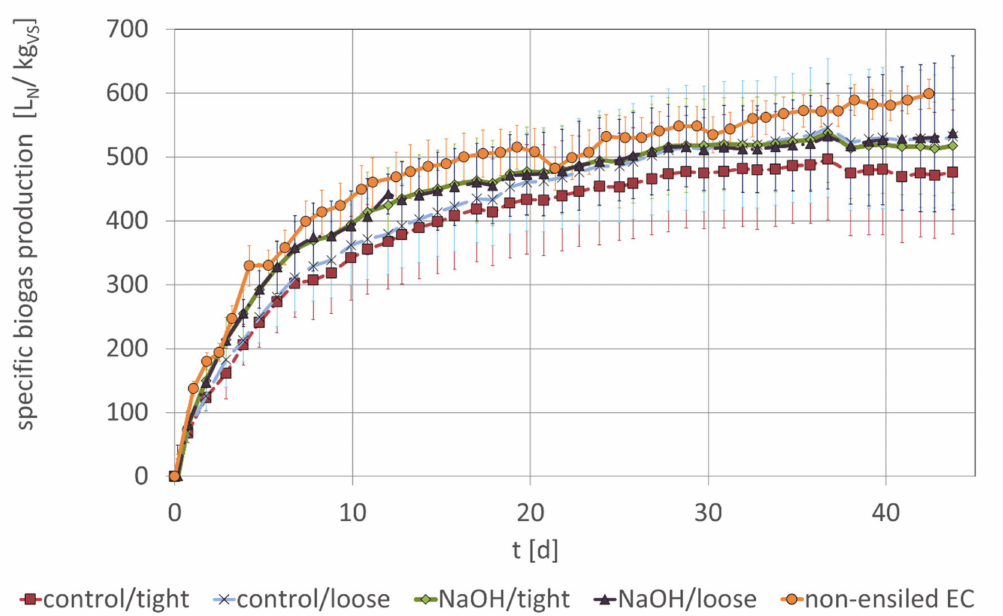
Figure 2. Specific biogas production of ensiled energy cane tightly and loose packed, with and without the addition of NaOH, and non-ensiled energy cane (EC) of lot